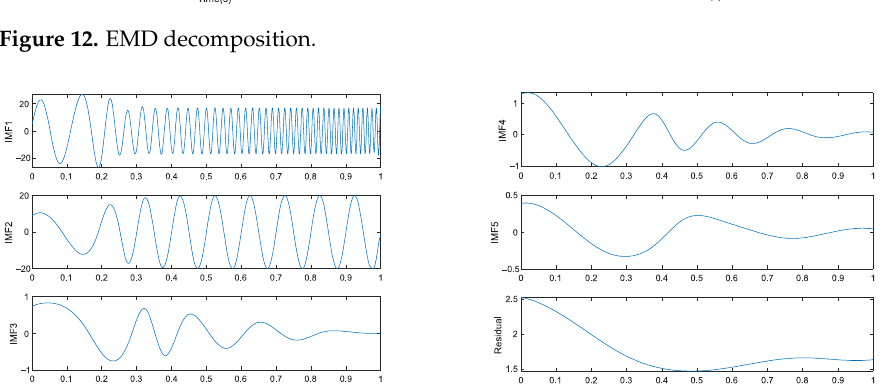
Table 3. Coefficients under EMD decomposition.